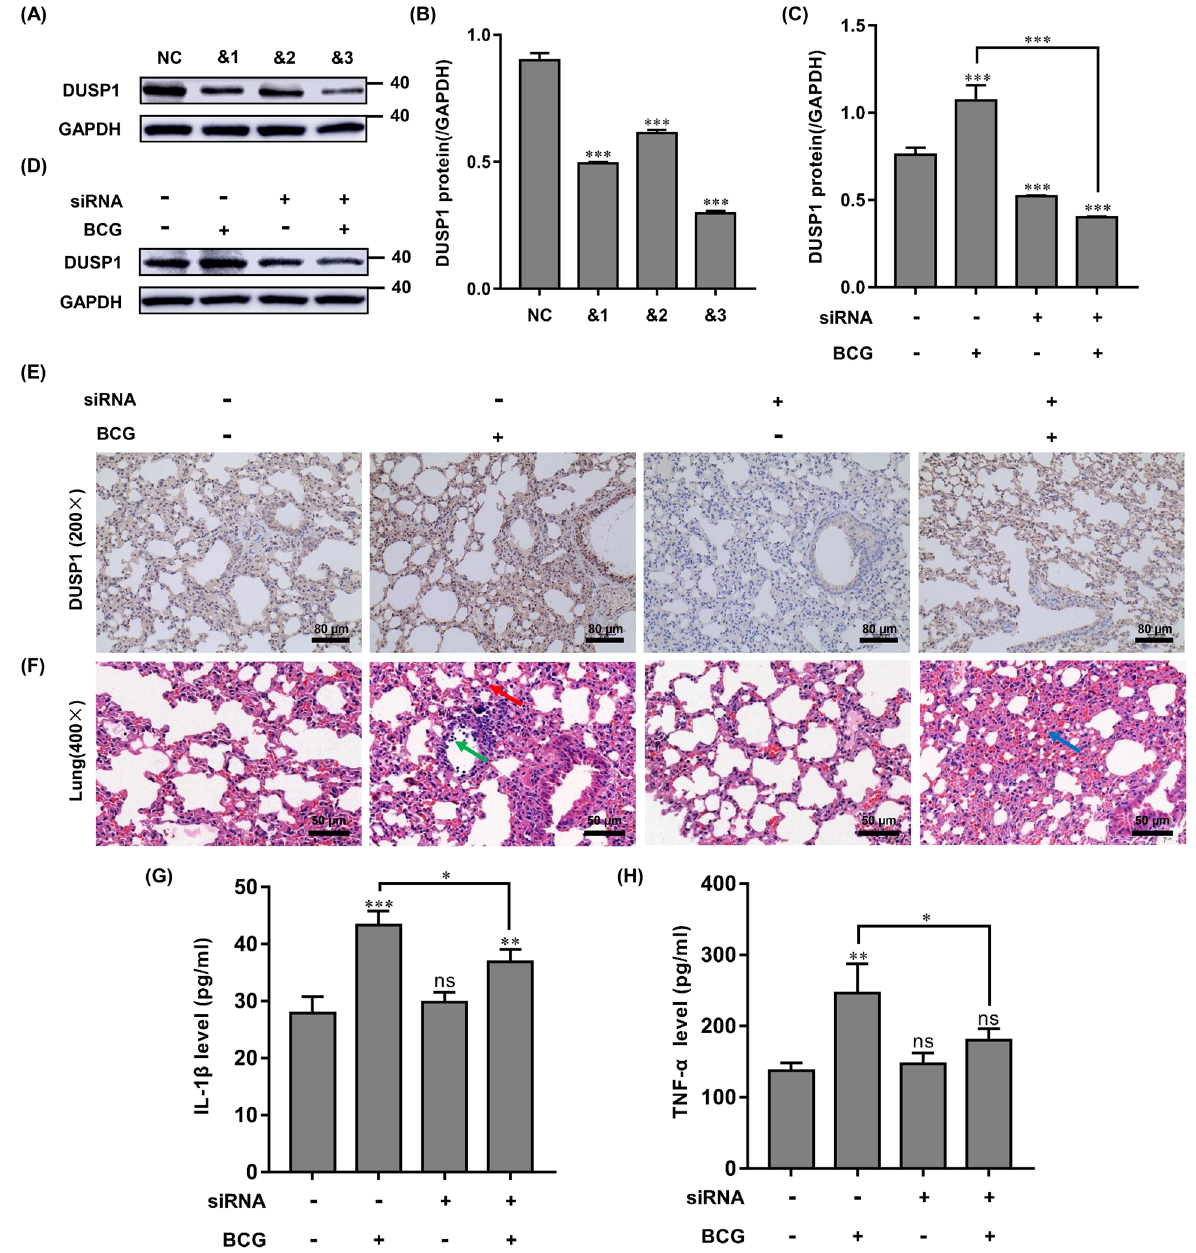
Figure 6. In vivo study of the effect of DUSP1 knockdown on BCG infection in a mouse model. ( A , B ) RAW264.7 cells were transfected with three different targeting siRNA-DUSP1 for 24 h, and the knockdown effect was verified by Western blotting. ( C , D ) RAW264.7 cells were transfected with siRNA-NC (negative control) or siRNA-DUSP1 for 24 h and then infected with BCG and cultured for 12 h. The expression of DUSP1 was detected using Western blotting. All data are represented as mean ± SD (n = 3). ( E ) C57BL/6J mice were infected with BCG by one-time direct airway perfusion (2 × 10 6 CFU/only), and siRNA-DUSP1 was used to intervene in the lung DUSP1 expression of C57BL/6J mice by multiple airway perfusion into the mice using in vivo Advanced Transfection Reagent. 21 days after BCG infection, lung tissue was taken from mice and immunohistochemistry was performed to detect DUSP1 expression in lung tissues. Scale bar, 40 μm. ( F ) C57BL/6J mice were infected with BCG by direct airway infusion (2 × 10 6 CFU/only) at one time, and siRNA- DUSP1 was infused into the lungs of C57BL/6J mice by multiple airway infusions using in vivo Advanced Transfection Reagent. 21 days after BCG infection, lung tissue was collected and analyzed for histopathological damage in the lungs of C57BL/6J mice by H&E staining. Scale bar, 50 μm. ( G , H ) The concentrations of TNF-α and IL-1β in the peripheral blood of mice in each treatment group were measured by ELISA, and the samples of mice in each treatment group were 6. (* p < 0.05, ** p < 0.01, *** p <